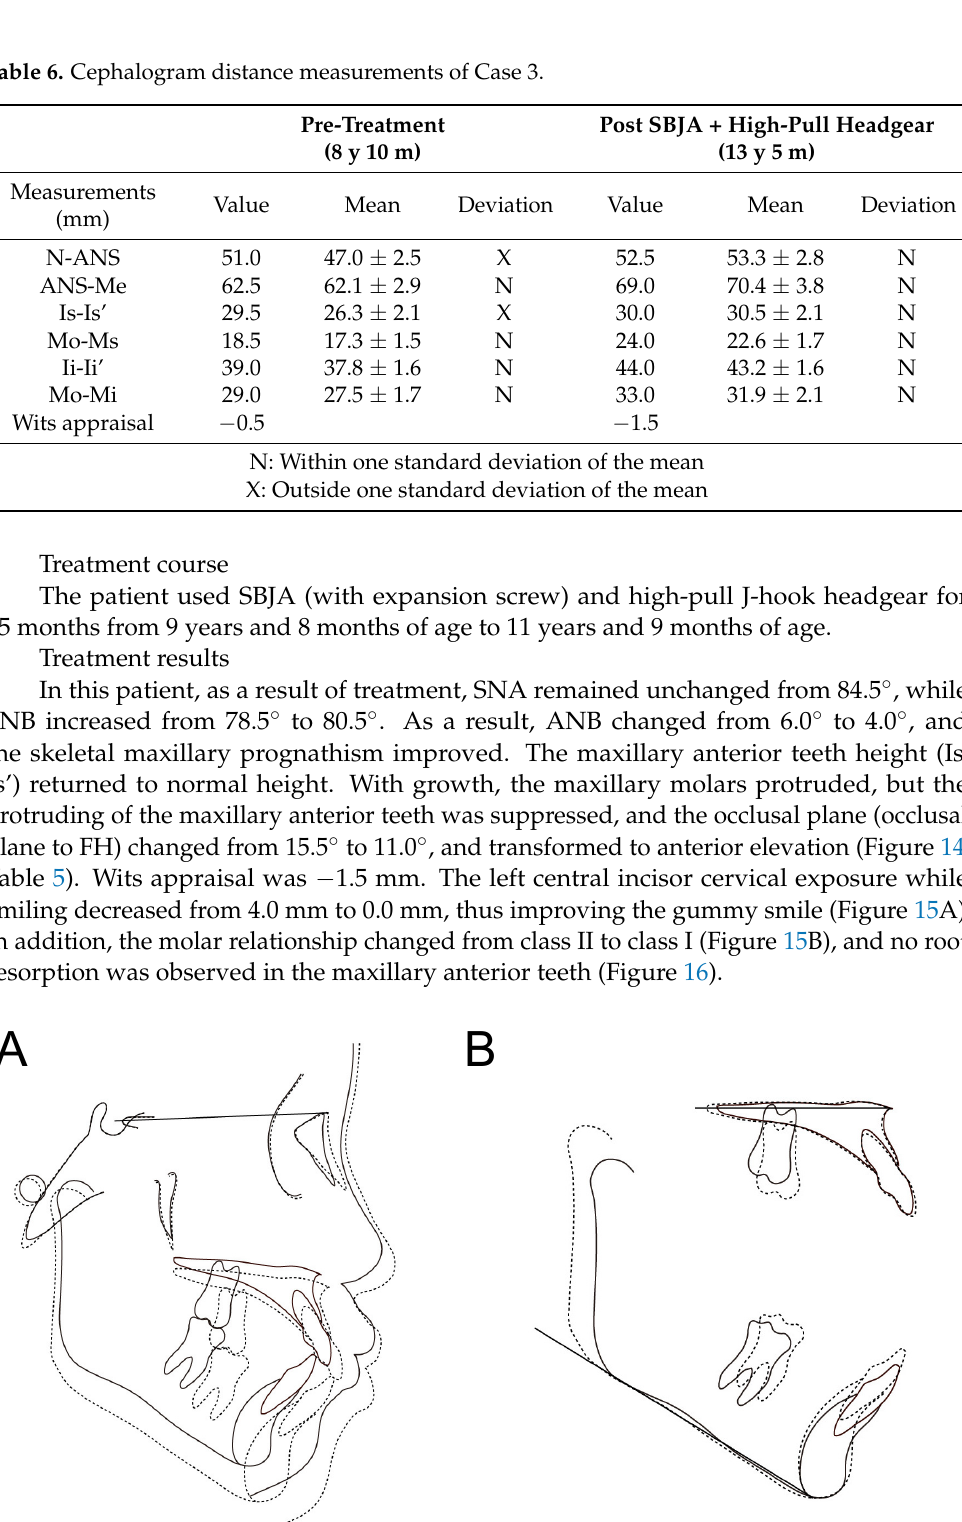
Figure 15. Facial photograph and intra-oral photograph of Case 3 at the end of the first stage of treatment. Facial photograph and enlarged photograph of the mouth at the end of the first stage of treatment ( A ); intra-oral photograph at the end of the first stage of treatment ( B ). Figure 16. Panoramic radiograph ( A ) and lateral roentgenographic cephalogram ( B ) of Case 3 at the end of the first stage of treatment. 3. Discussion All three cases in this study were in their growth period, and gummy smiles caused by the overeruption of maxillary anterior teeth were observed. There have been various reports on the causes and ways of improving gummy smiles [2,4–6,9,10]. However, there